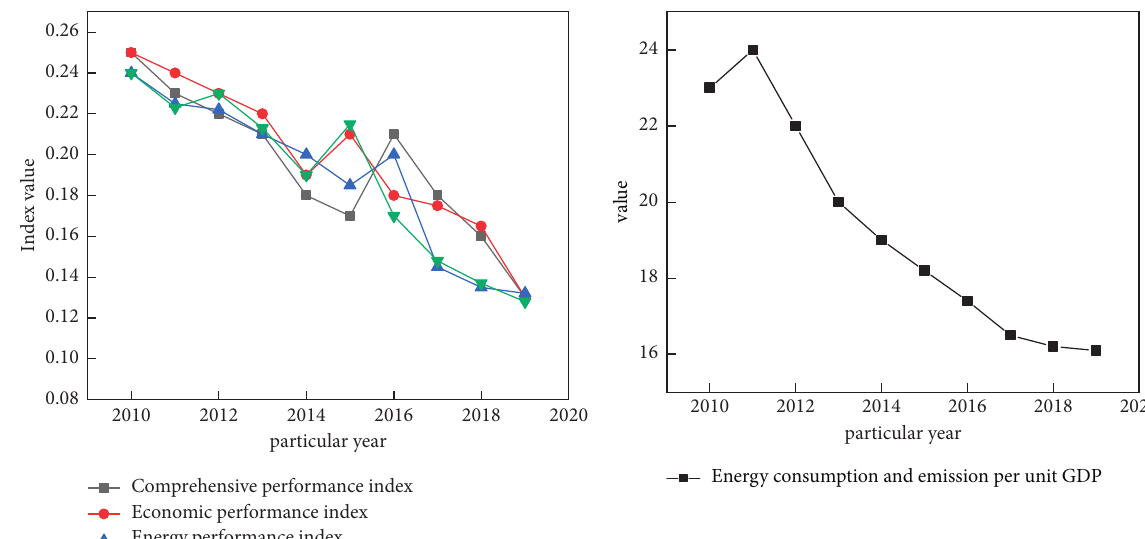
Figure 9: Trend index of reducing consumption of energy and energy consumption per unit GDP.